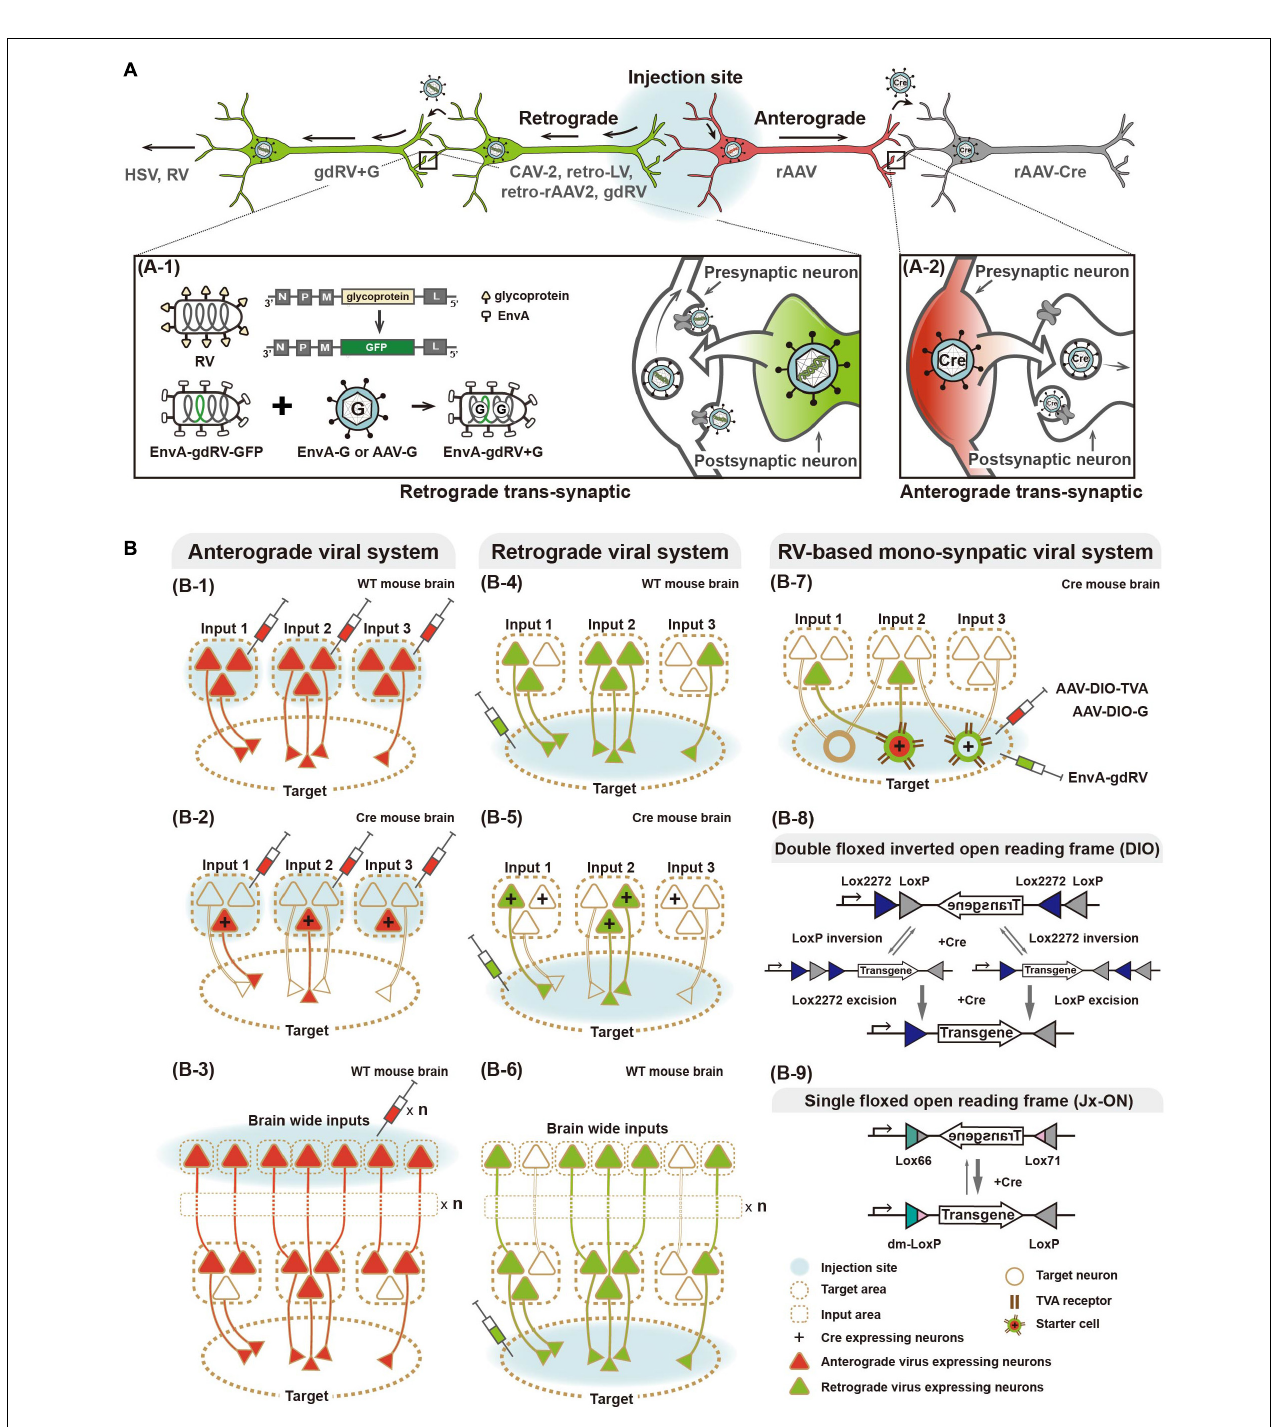
FIGURE 1 | Viral systems for visualizing input convergent circuitry and delivering genetic tools for functional input mapping. (A) Schematic illustration of antero-, retrograde, and transsynaptic viral tracers. Anterograde virus (red) and retrograde virus (green) are distinguished by their neural entry site and axonal transport directions. Several viruses can cross synapse(s) and enter the connected neurons. Transsynaptic delivery of retrograde virus and engineered rabies virus, as an example of trans-synaptic retrograde viral tracers, are illustrated (A-1). Anterograde transsynaptic delivery of AAV 1 or 9 expressing Cre is illustrated (A-2). (B) Schematic illustration of labeling strategies of various viral systems. For convergence circuit mapping, anterograde virus to the multiple input areas (B-1–3) or retrograde virus to a target area (B-4–6) can be injected. Engineered rabies virus (RV) labels convergent circuits to the cell type neuron in the target area (B-7). Furthermore, antero- and retrograde polysynaptic viruses enable identifying neural circuitries integrated cross multiple synapses by injecting input and target areas, respectively (B-3,6). Two schematic strategies of Cre-dependent viral vectors for labeling particular cell types, such as Double floxed inverted open reading frame (DIO) and single floxed version (Jx-ON) (B-8,9).